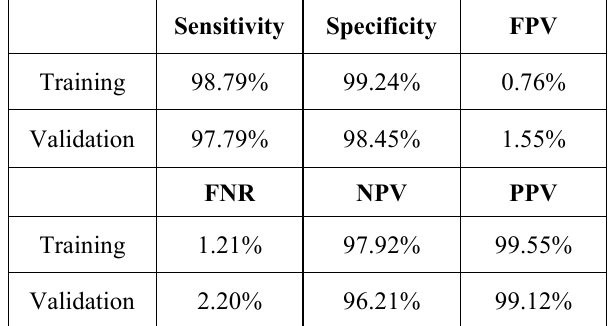
Table 5. Comparison with previous work with the